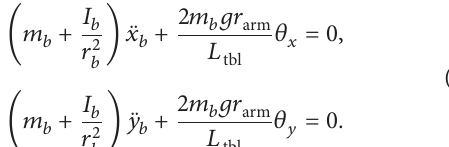
Figure 3: Time history and FFT analysis results of measument signal.